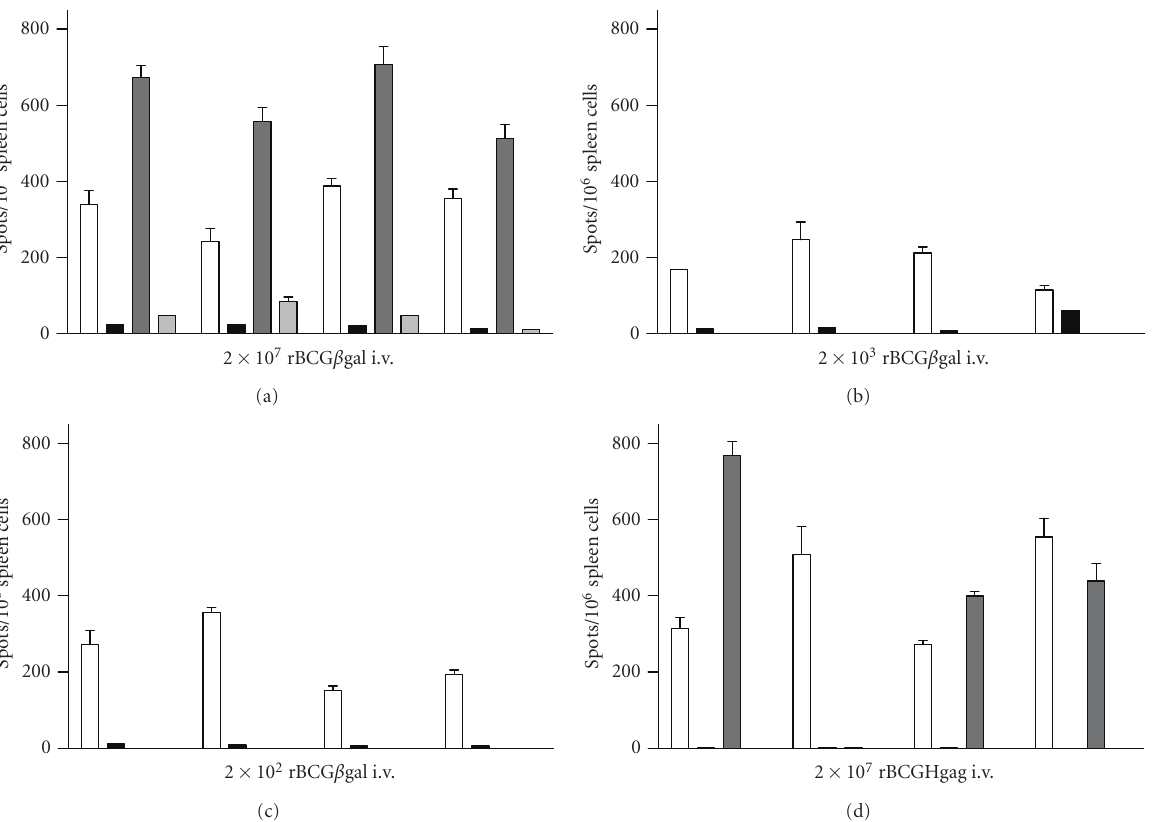
Figure 1: Immune response of four individual mice per group after i.v. immunization with di ff erent doses of recombinant BCG (rBCG β gal) or control rBCG expressing HIV gag protein (rBCGHgag). Immunization dose is indicated below each graph. Mice were immunized as indicated under each graph. After 9 weeks, the mice were killed and the number of β -gal- and BCG-specific IFN γ - and IL-4-producing cells in their spleens was determined by ELISPOT assay. The response in mice given a high dose of BCG transformed with a control vector containing the HIV gag sequence is also shown. Open bars—IFN γ response to BCG; Black bars—IFN γ response to β -gal; Dark gray bars— IL-4 response to BCG; Light gray bars—IL-4 response to β -gal. All values were corrected for background by subtracting the number of spots observed in wells without antigen. Results are representative of two independent